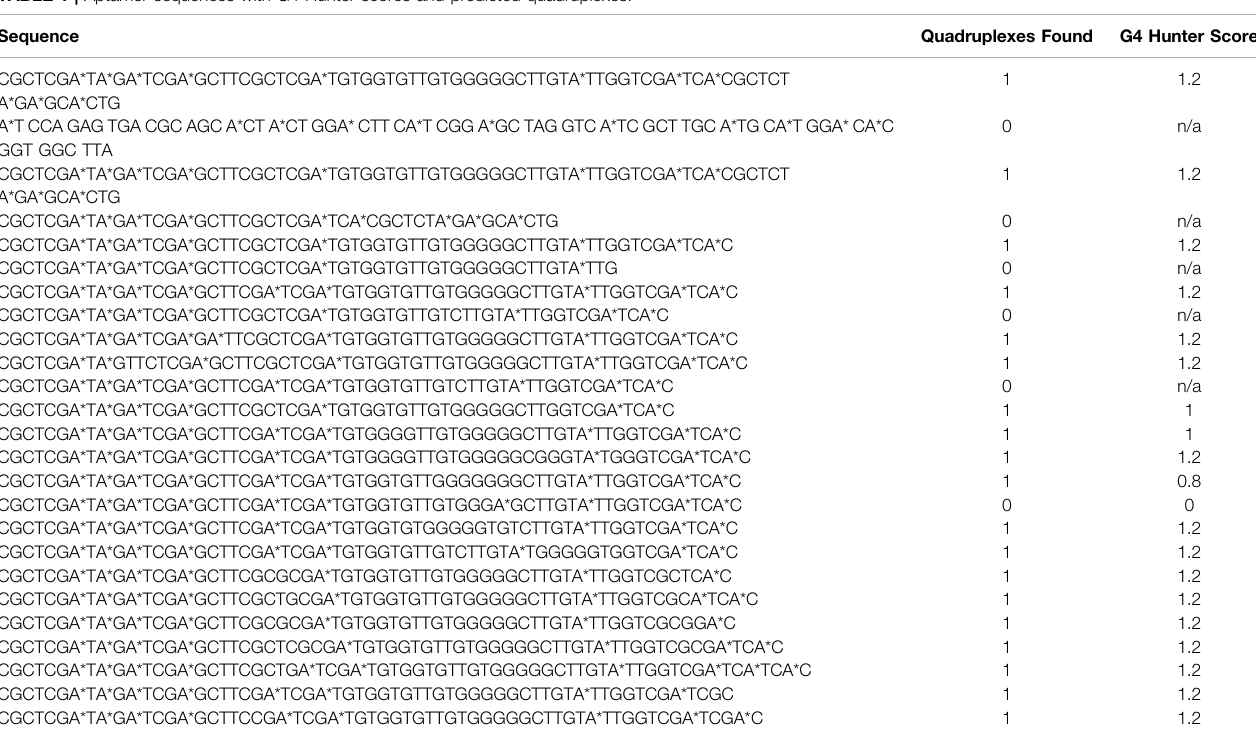
TABLE 1 | Aptamer sequences with G4 Hunter scores and predicted quadruplexes.